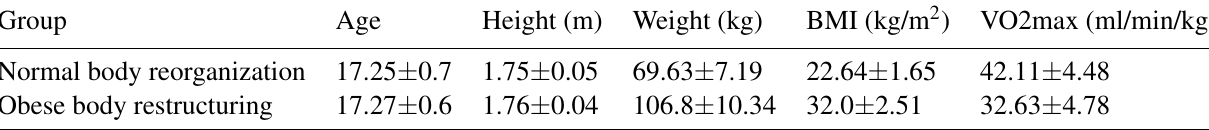
Table 1 Basic situation of research